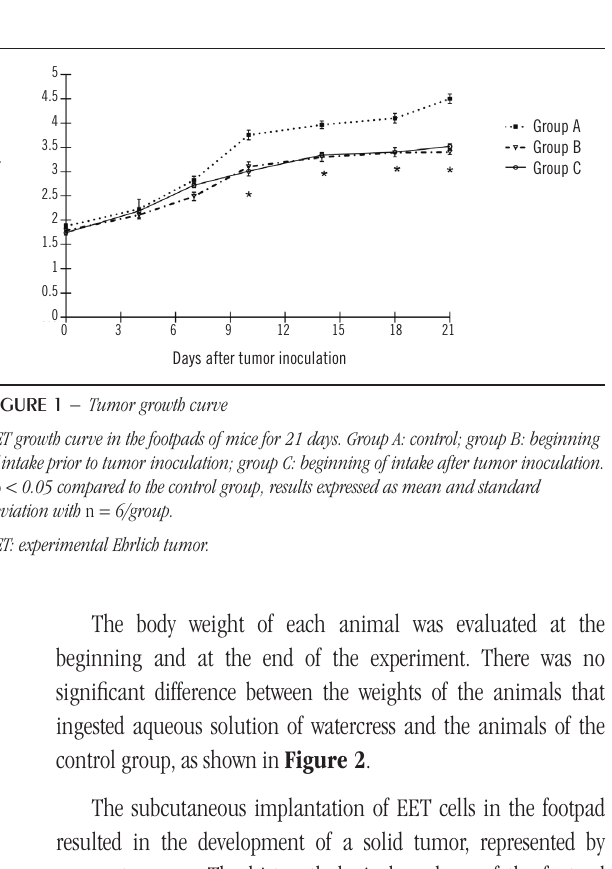
Group A Group B Group